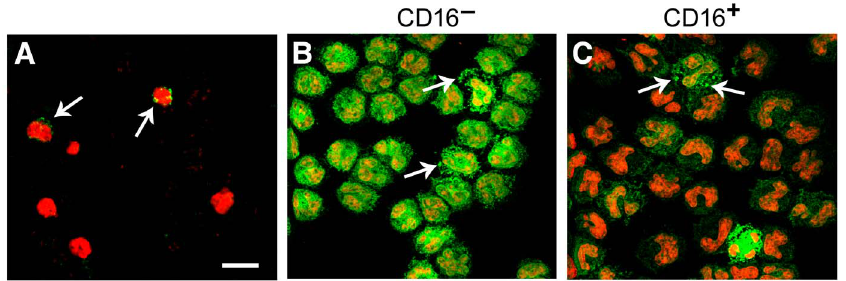
Figure 2. Integrin a D b 2 is expressed by inflamed murine leukocytes and by unstimulated circulating human monocytes. A. Leukocytes in whole cardiac blood from a mouse infected with the rodent malarial parasite Plasmodium berghei ANKA [14] were stained for a D b 2 (arrows). B, C. Monocytes were first separated from an unfractionated mononuclear cell suspension from the peripheral blood of a healthy human volunteer and then further separated into CD16 + and CD16 2 subpopulations as described in Materials and Methods. The CD16 2 CD14 + (B) and CD16 + (C) monocyte preparations were then fixed, permeabilized, and stained for a D (green fluorescence) using anti- a D mAb 169A. Propidium iodide was used to identify nuclei. In additional experiments isotype-matched non-immune IgG was used as the first immunoglobulin in the staining procedure to control for mAb 169A (Figure S2). In both monocyte subsets, a D b 2 staining had a granular pattern and in some areas there were large clusters of the integrin that appeared to be on or near the surface (arrows). An additional experiment indicated that a D b 2 also clusters on human neutrophils (Figure S3).